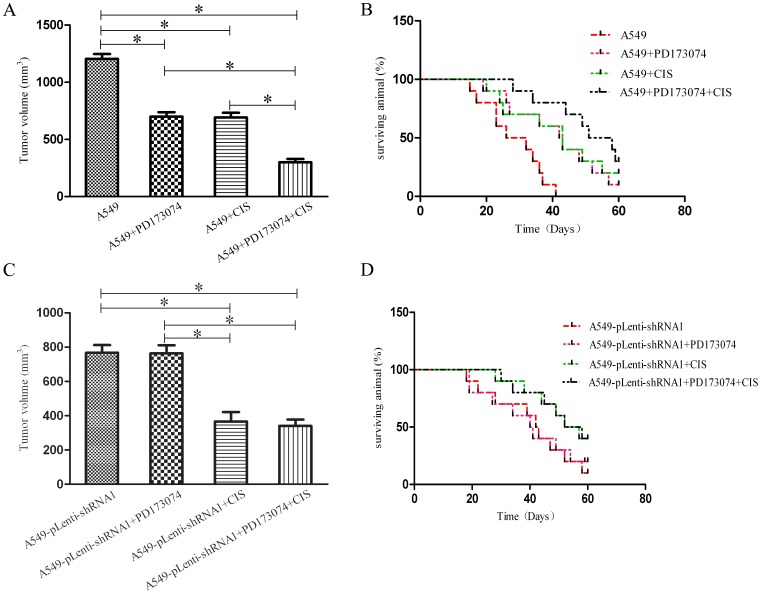
PD173074 inhibition of cell proliferation, cycle transition, and apoptosis resistance depends on the TC-1 expression level in vivo.Subcutaneous tumor model (n = 10). A549- pLenti-shRNA1 or A549 cells were implanted into the flank of nude mice. PD173074 or buffer alone was administered daily for 28 days. In addition, the mice received or did not receive two doses of 5 mg/kg cisplatin i.v. on days 1 and 15. (A, C) The tumor volumes were scored 28 days after the first administration of PD173074. (B, D) The animal survival was recorded as a Kaplan-Meier plot. The columns represent the average tumor volume. The bars show the SE. *indicates statistically significant changes (Student’s t test, P<0.05) between two groups. CIS, Cisplatin.